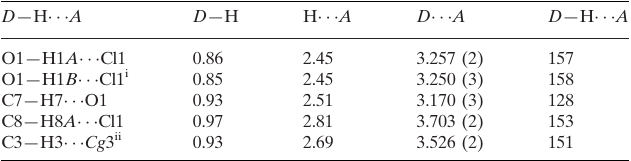
Hydrogen-bond geometry (A˚ , (cid:4) ). Cg 3 is the centroid of the C9–C14